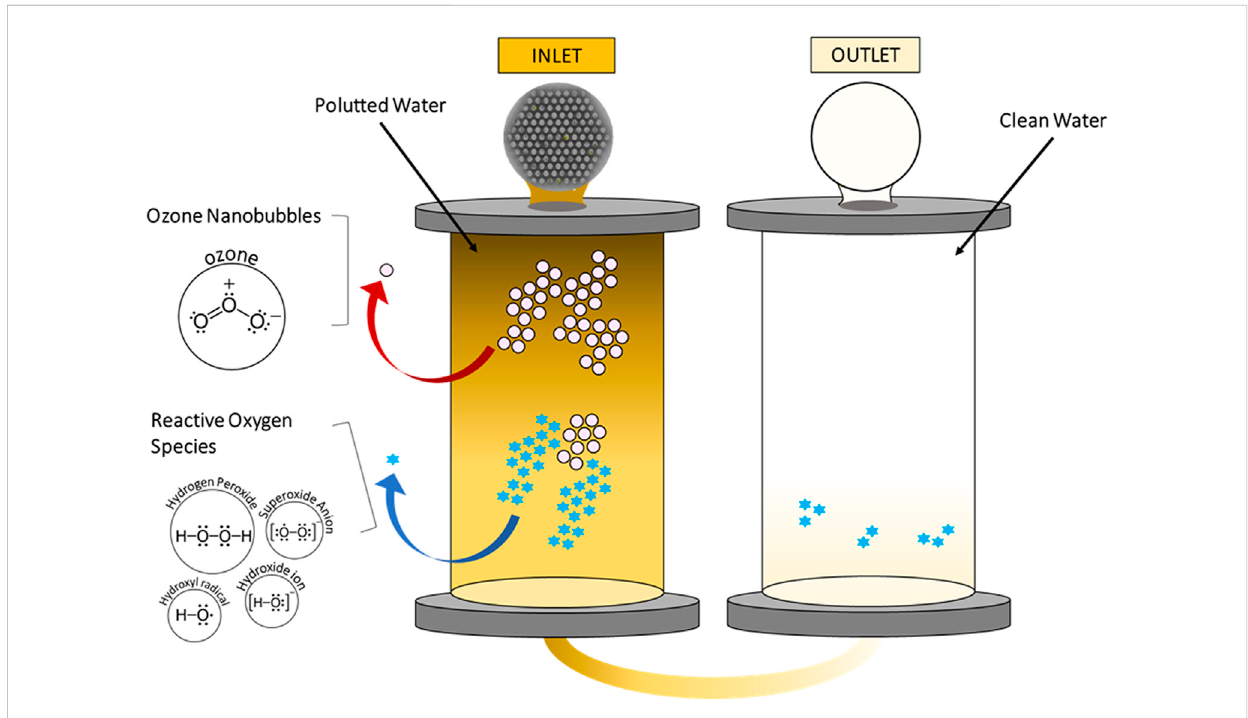
FIGURE 7 Schematic illustration of pollutant degradation in our